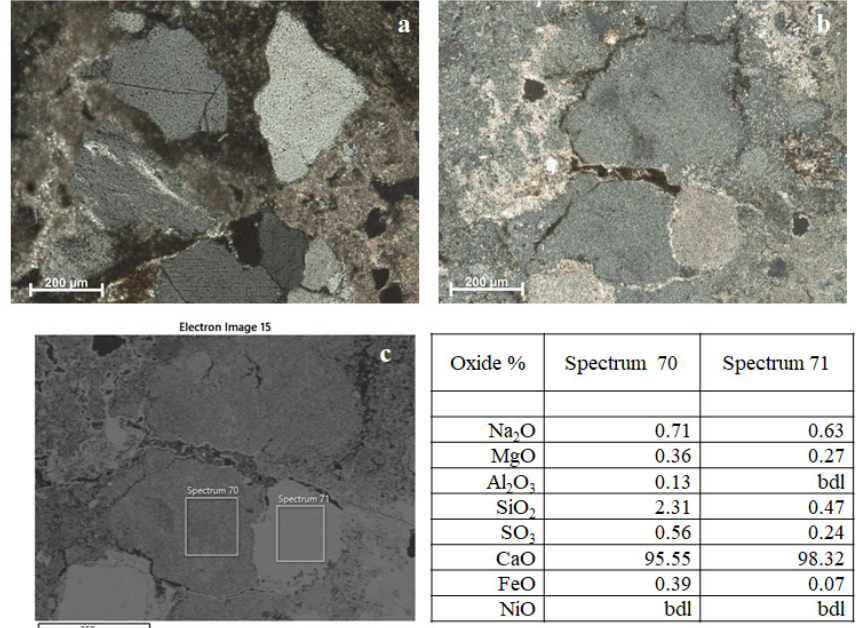
Figure 12. Microphotographs of the binder of a bedding mortar of a Roman aqueduct (Quarto-Florence) with grey areas; ( a ) under PLM, xpl; ( b ) particular of an area of binder of a bedding mortar of Roman findings (Spello, Perugia, Italy) with different birefringence color under PLM, xpl; and ( c ) BS SEM image of same area of ( b ) and micro chemical analyses of selected areas in the previous image.